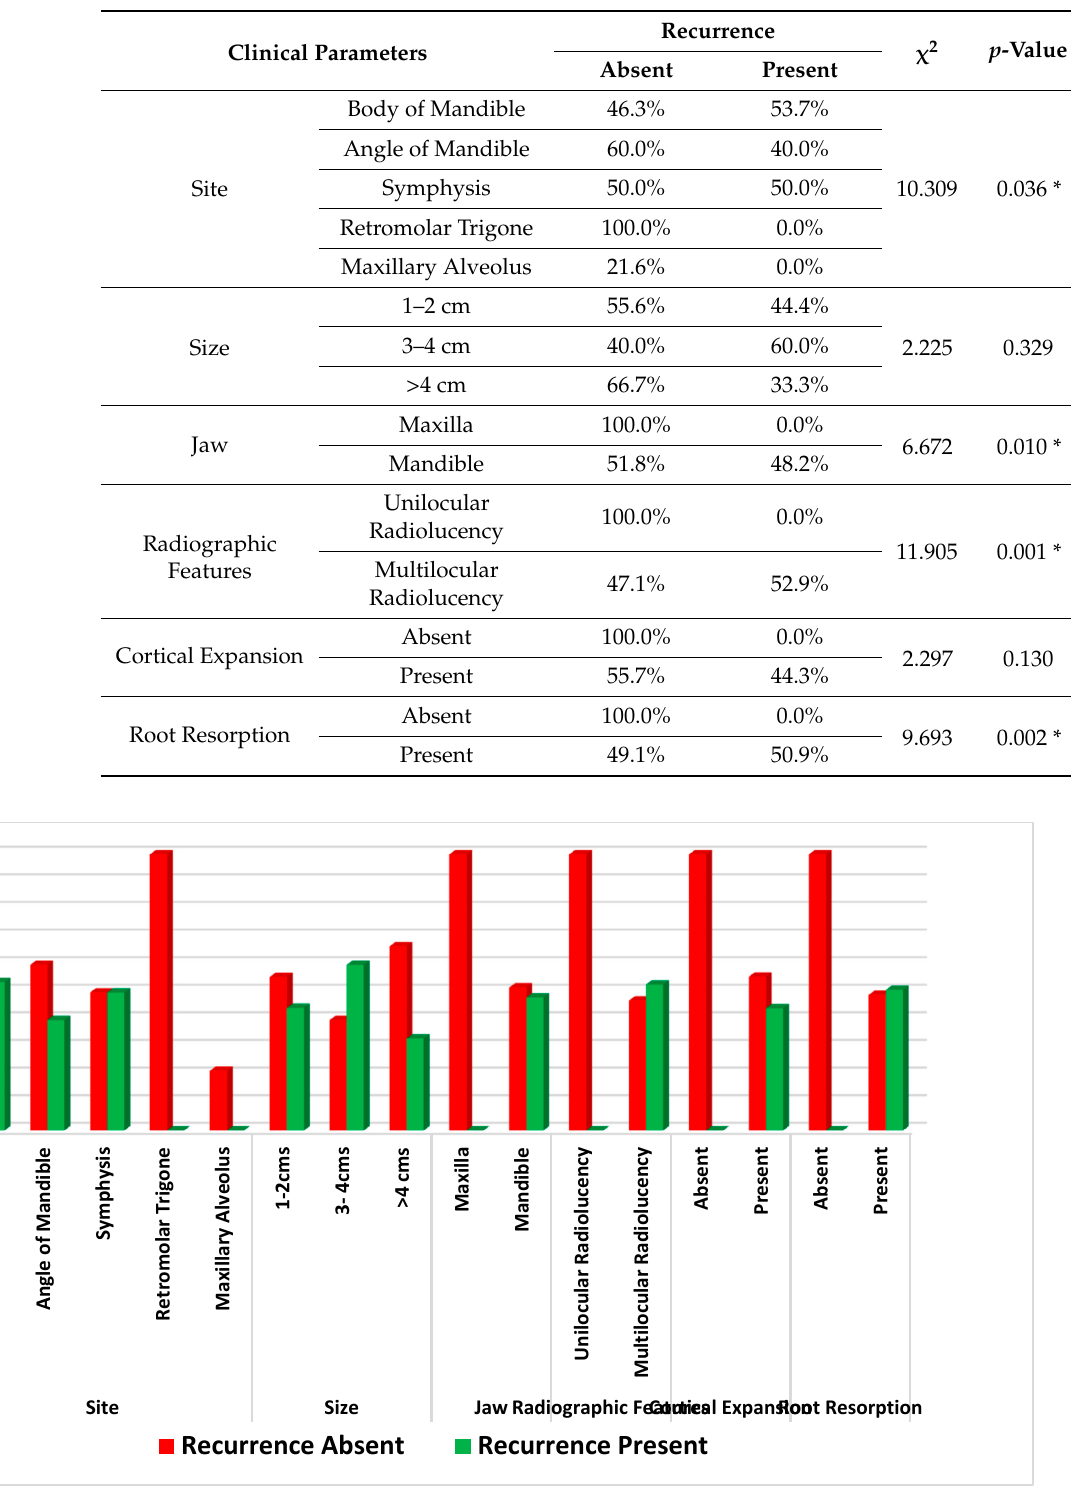
Figure 3. Comparison of correlation of clinical parameter with recurrence of solid multicystic ame- Figure 3. loblastoma.